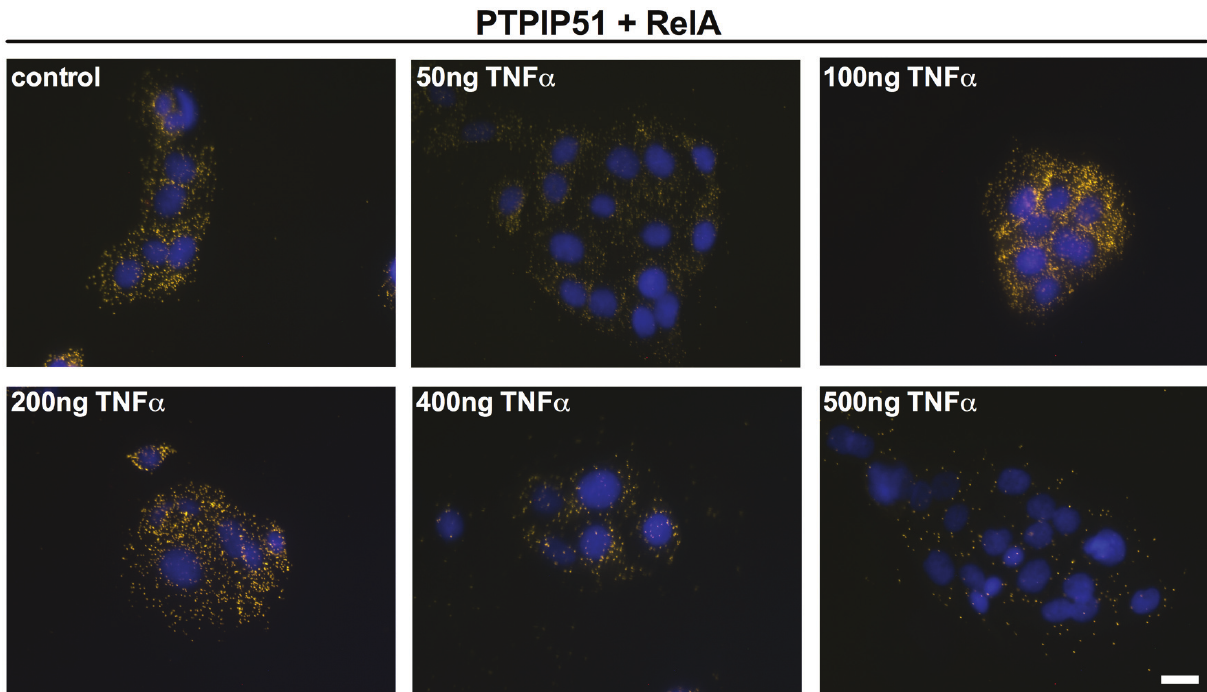
Figure 5. Interactions of PTPIP51 and RelA in human keratinocytes determined by Duolink proximity assay. Untreated controls, 50 ng/mL TNF(cid:3) treated cells, 100 ng/mL TNF(cid:3) treated cells, 200 ng/mL TNF(cid:3) treated cells, 400 ng/mL TNF(cid:3) treated cells, 500 ng/mL TNF(cid:3) treated cells. Bar: 20